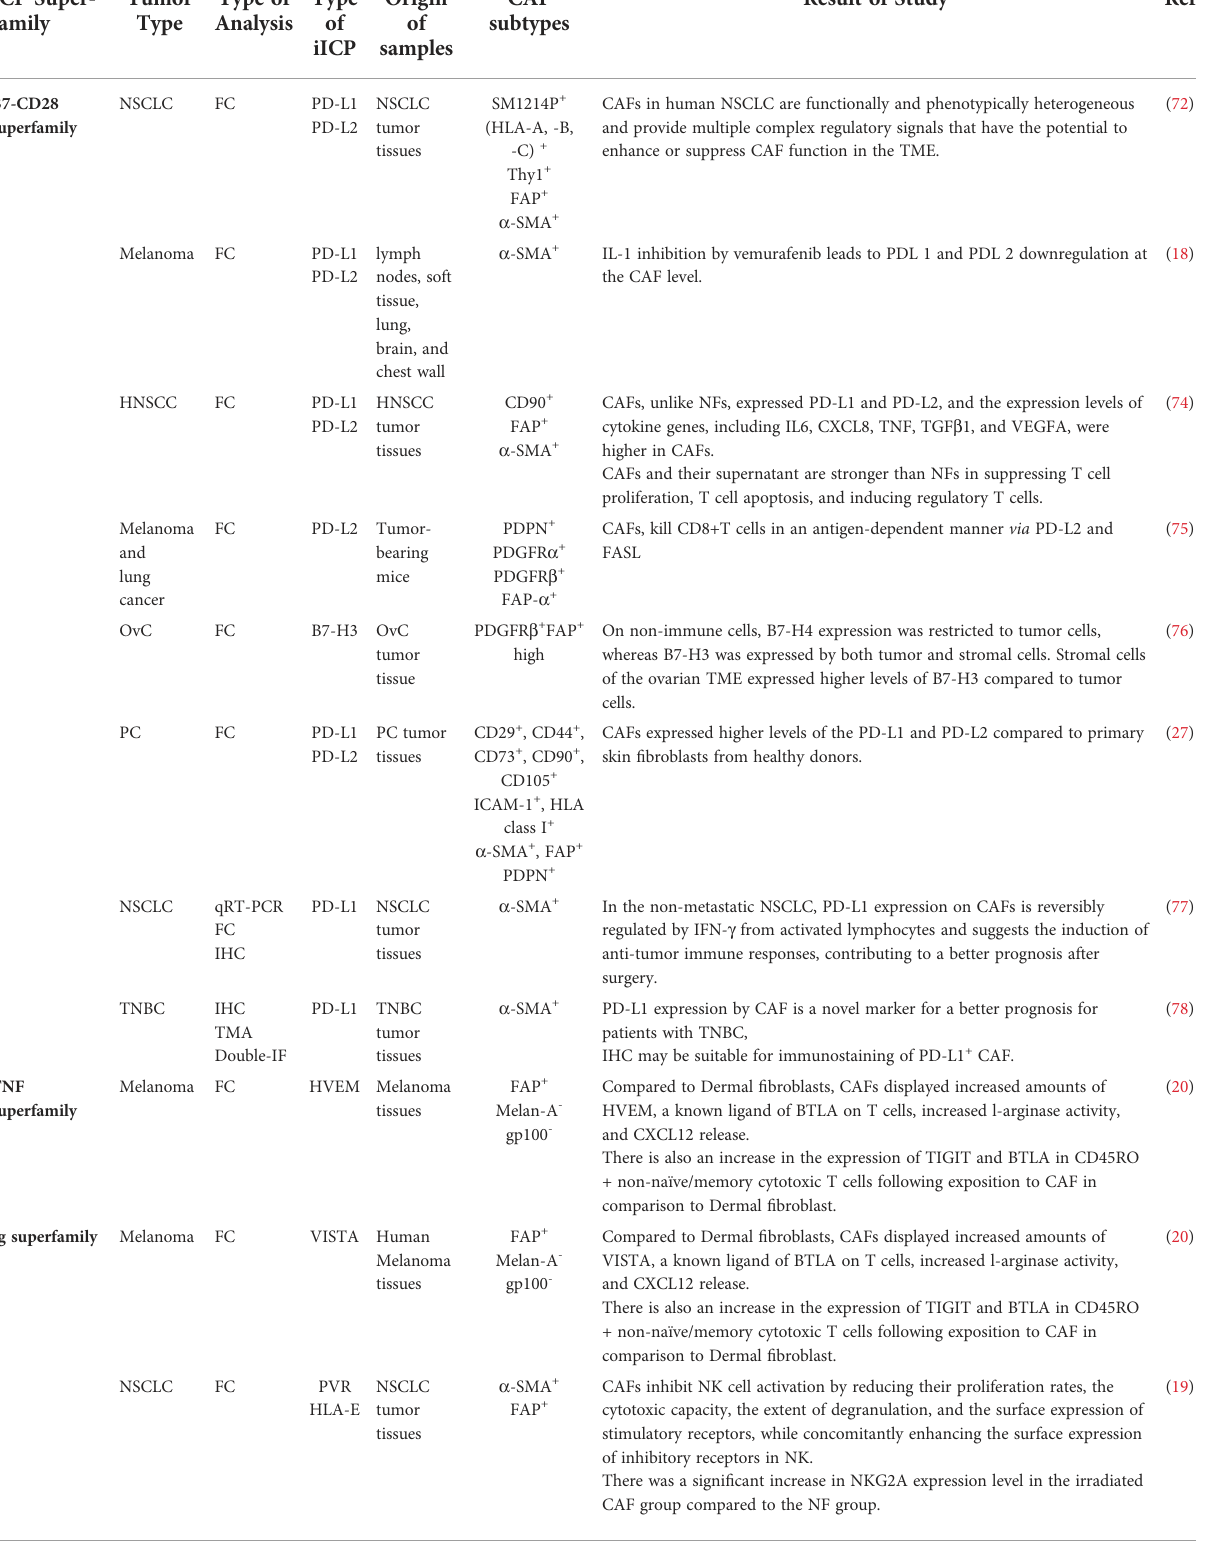
TABLE 1 List of the induced or over-expressed iICP and their ligands on CAFs in different tumors. ICP Super-